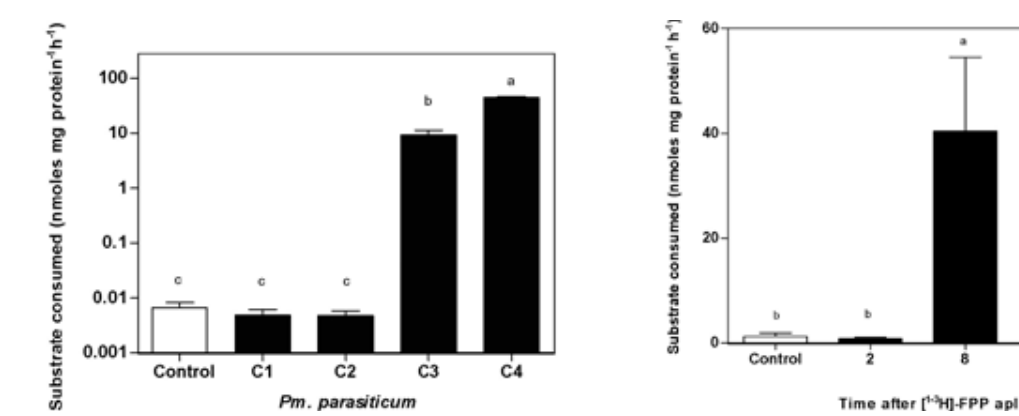
Figure 2. TPS activity expressed as nmoles of [ 1-3 H]-FPP consumed per mg protein -1 h -1 of cell suspension cultures at 2, 8, 72 and 96 h post application of FPP radioactive, and previously inoculated with 1 mL of 10 6 conidia mL -1 of Pm. parasiticum